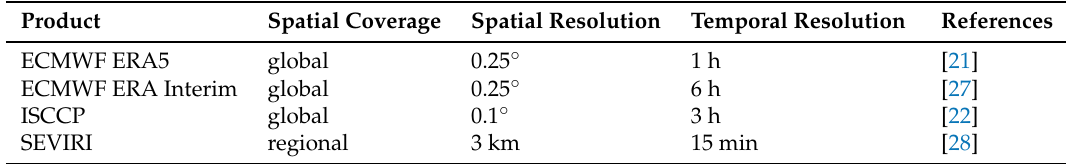
Table 2. Characteristics of the Land Surface Temperature (LST) products from the ECMWF reanalyses and from the infrared